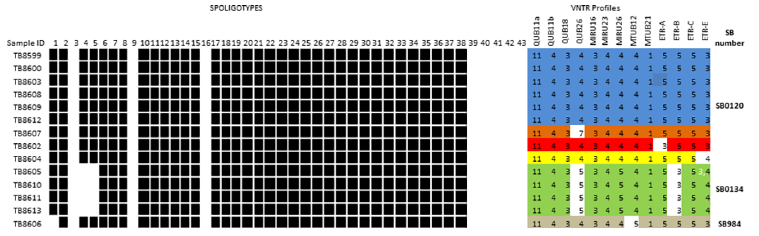
Fig 1. Spoligotype patterns with their SB-numbers retrieved from www. Mbovis.org of 14 M. bovis isolates (TB numbers) and VNTR profiles with their designations (ER-1 -ER-6) from tissues with TBLs collected at the Asmara municipal